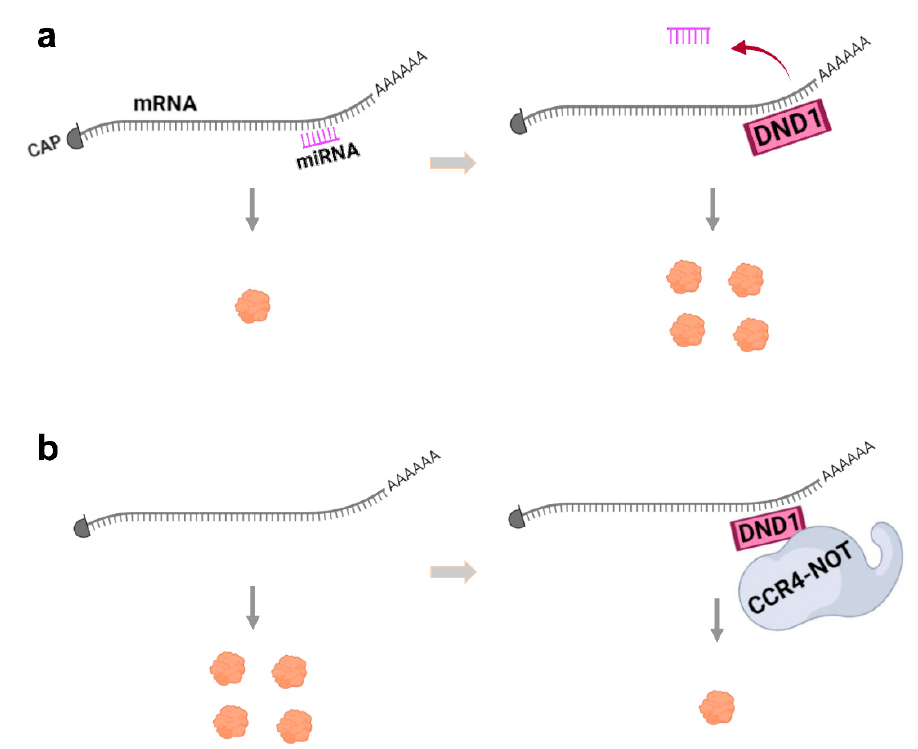
Figure 2. The two major mechanisms of DND1 function. ( a ) Interaction of DND1 with mRNA blocks miRNA access to mRNA to up-regulate translation and protein expression. ( b ) DND1 can also bind to mRNA to target it for destruction by the CCR4-NOT complex, thus decreasing translation and protein expression. These mechanisms may be cell-type- or mRNA-specific.